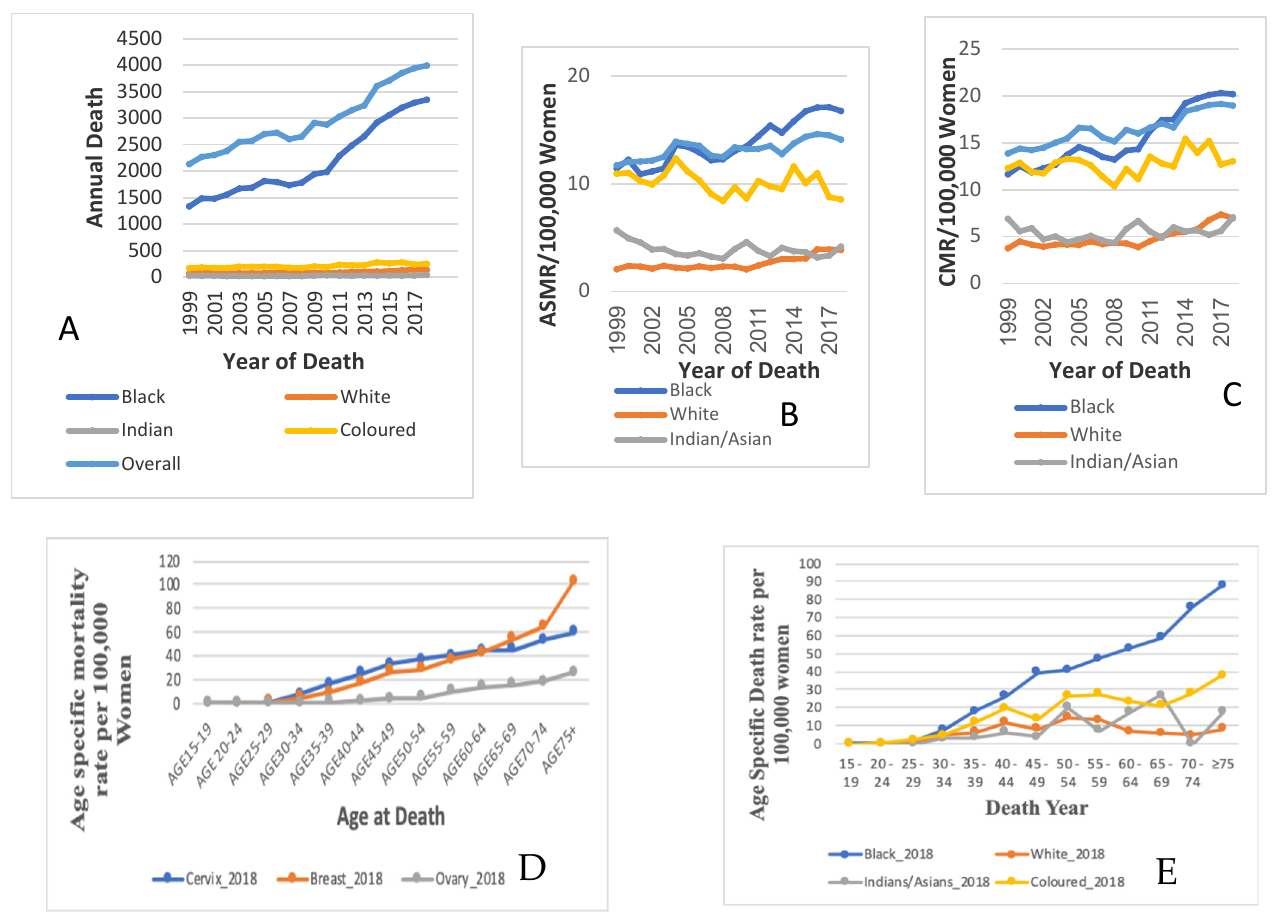
Figure 1. A. Overall age-specific death rates in 2018 in South Africa from ( A ) breast and cervical cancer. National and ethnic annual deaths: ( A ), age-standardised mortality rates; ( B ) crude mortality rates; ( C ) age-specific mortality rates; ( D ) Comparison of age-specific death rates for cervical cancer, breast cancer, and ovarian cancer in South Africa, 2018; and ( E ) rates of cervical cancer in South Africa (1999–2018).